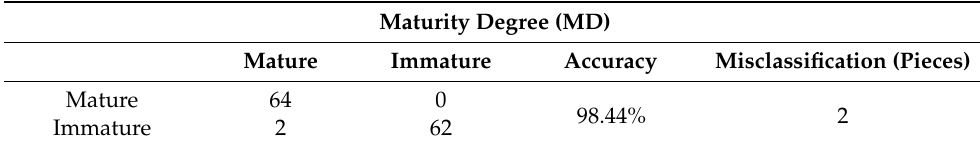
Table 8. “Maturity degree” (MD) classification